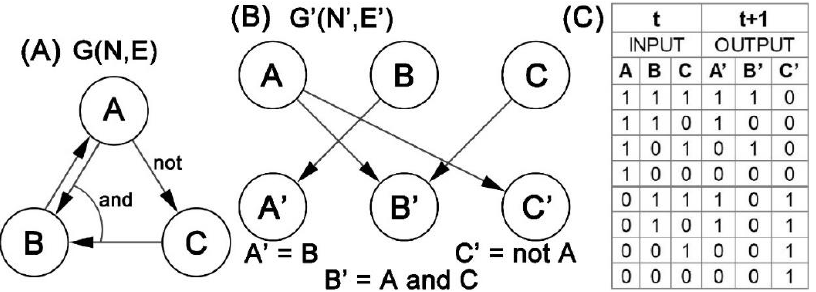
Figure 4. Example of a Boolean network. ( A ). A simple Boolean network 𝐺(𝑁, 𝐸) . ( B ). The state transition corresponding to the linkage graph 𝐺′(𝑁′, 𝐸′) of A. ( C ). The truth table of this network.